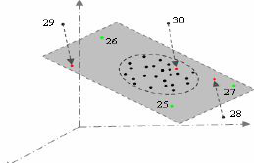
Figure 1. Fitted plane, green points are distant in terms of score and red points are orthogonal